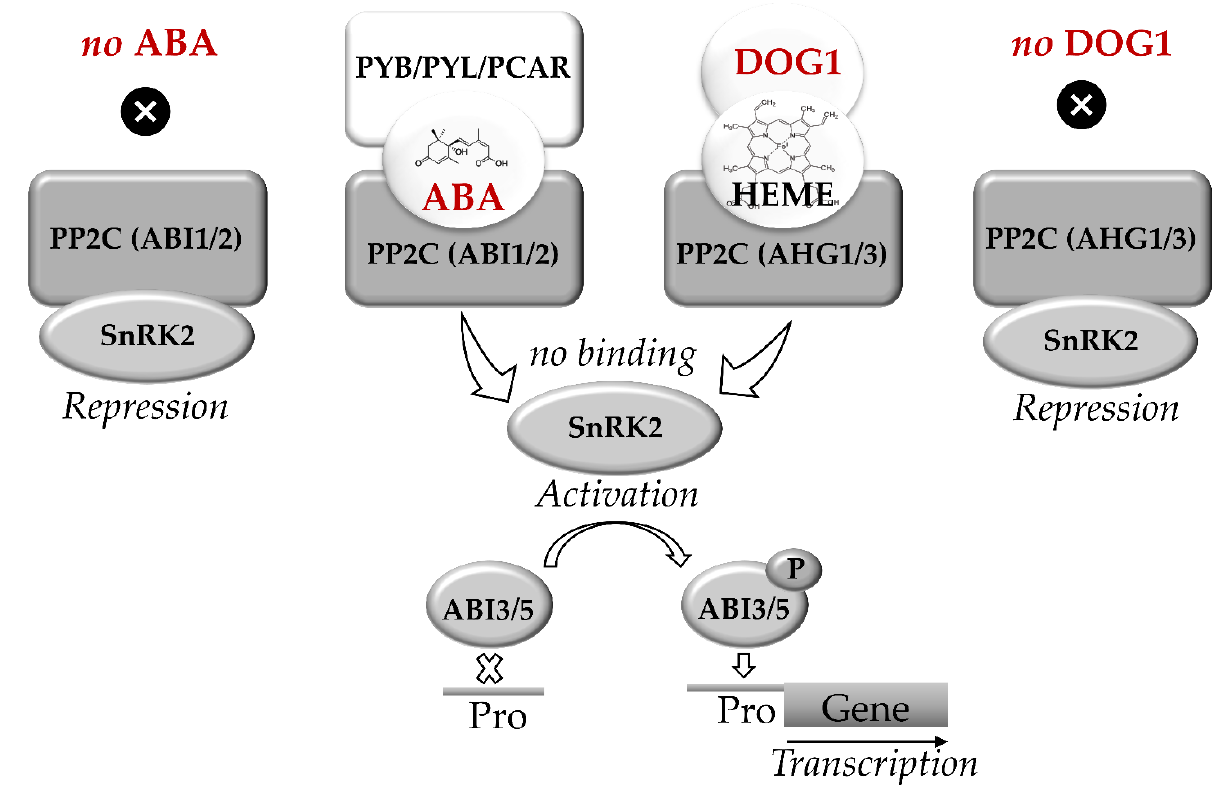
Figure 2. Abscisic acid (ABA) and DELAY OF GERMINATION 1 (DOG1) signaling pathways in seeds. C encoded by ABI1 and ABI2 genes. The key elements of DOG1 signaling are heme molecule and PP2Cs encoded by AHG1 and AHG3 genes. Triplex complexes of PCAR-ABA-PP2C and/or DOG1-HEME-PP2C block the binding of PP2C to SnRK2. The active SnRK2 phosphorylates ABI3 and ABI5 which bind to the promoters (Pro) of ABA-controlled genes. In seeds, the parallel ABA and DOG1 signaling pathways activate synthesis of RFO, expression of LEA and HSP genes, thus regulating the onset of desiccation tolerance and transit to dormancy. Based on [34,60,82,87,97,98].